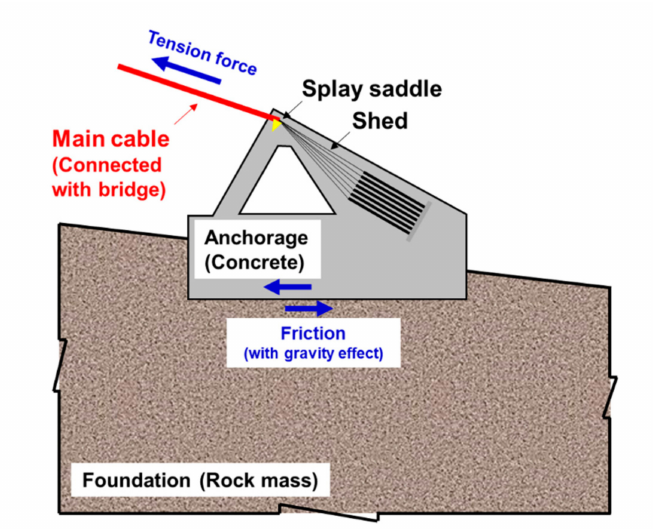
Figure 1. Schematic diagram for a gravity-type anchorage in a ground-anchored suspension